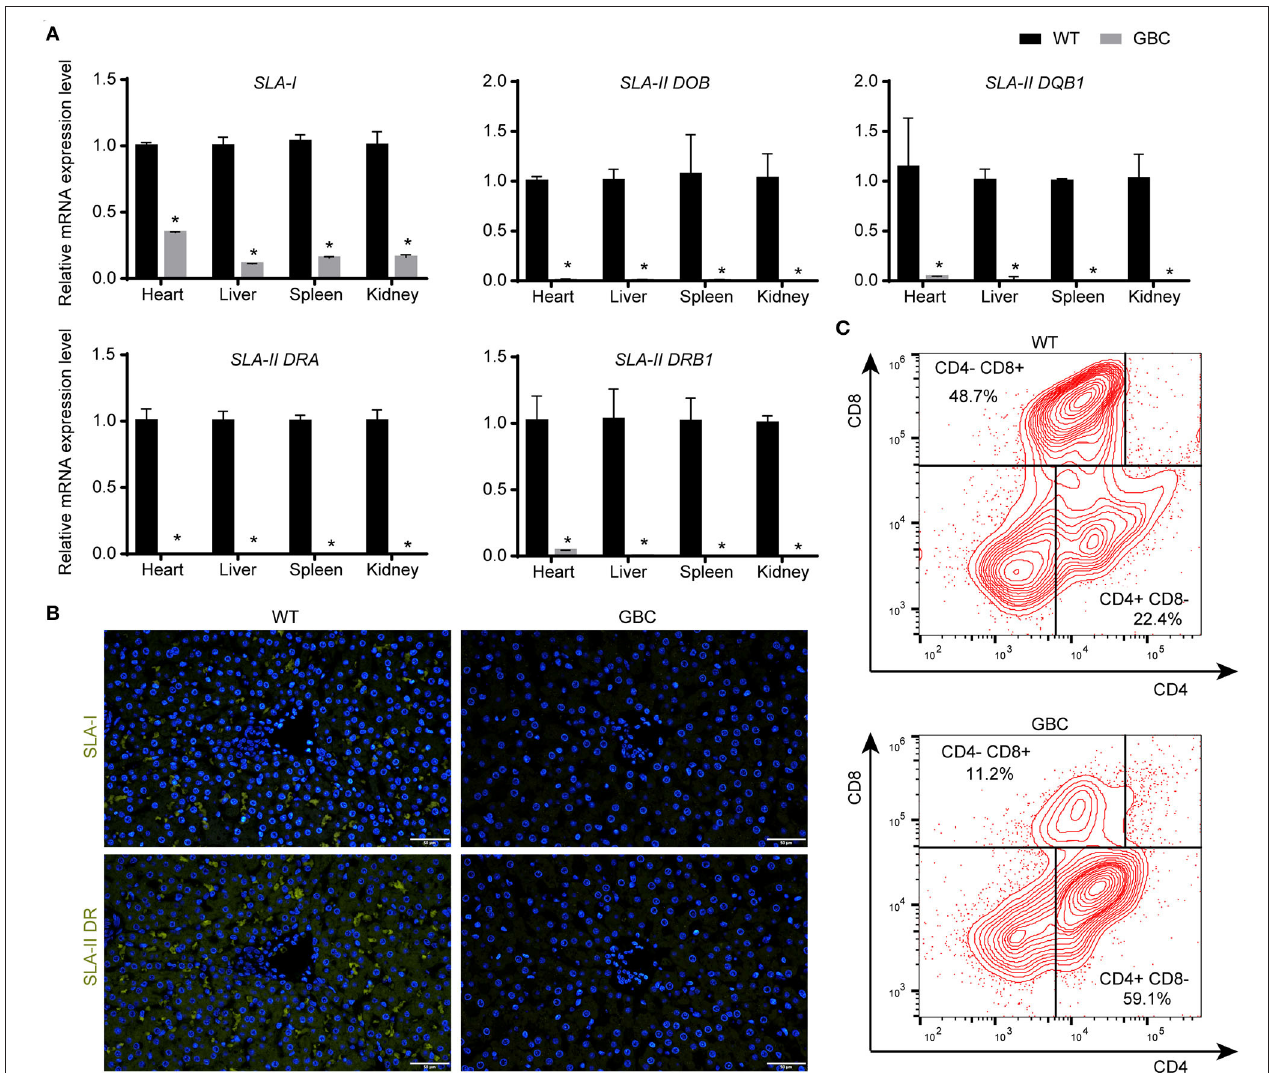
FIGURE 4 | Expression of SLA-I and SLA-II genes, and alteration of T-cell subtype (CD4 and CD8) in GBC-modified pigs. (A) The mRNA expression levels of SLA-I and four isoforms of the SLA-II gene in the heart, liver, lung, and kidney (* P < 0.05 vs. WT). (B) Immunofluorometric analysis of SLA-I and SLA-II DR molecules in the liver (scale bar = 50 µ m). (C) The percentage of CD4 + /CD8 − and CD4 − /CD8 + T-cells in PBMCs derived from WT and GBC-modified